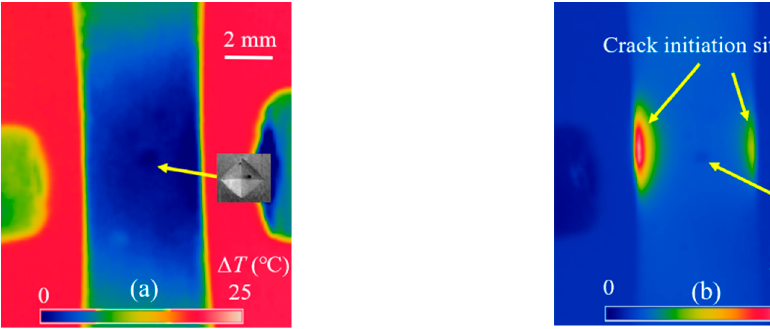
Figure 7. The temperature distribution of the specimen surface obtained by thermography in a 20% CW 316L specimen (indent depth is 45 µ m) tested at 380 MPa, which failed at 2.75 × 10 6 cycles. ( a ) Before fatigue test; ( b ) just before fatigue failure. Note: ∆ T is defined as the specimen temperature changes with respect to minimum temperature at the initial state, as well as in Figure 8.